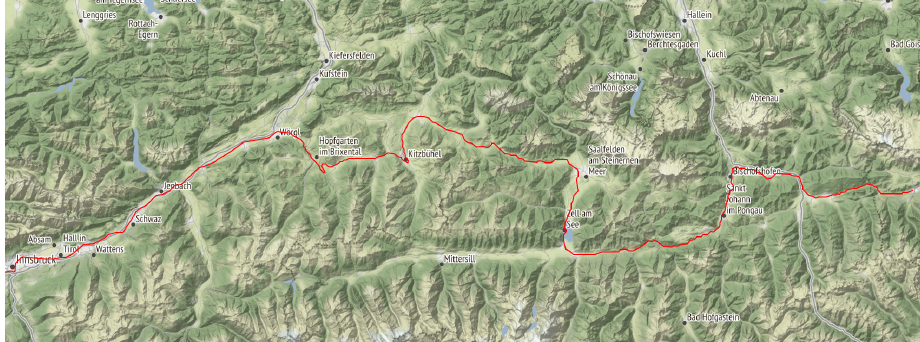
Figure 8. Train route for CS2, 29 November 2019.